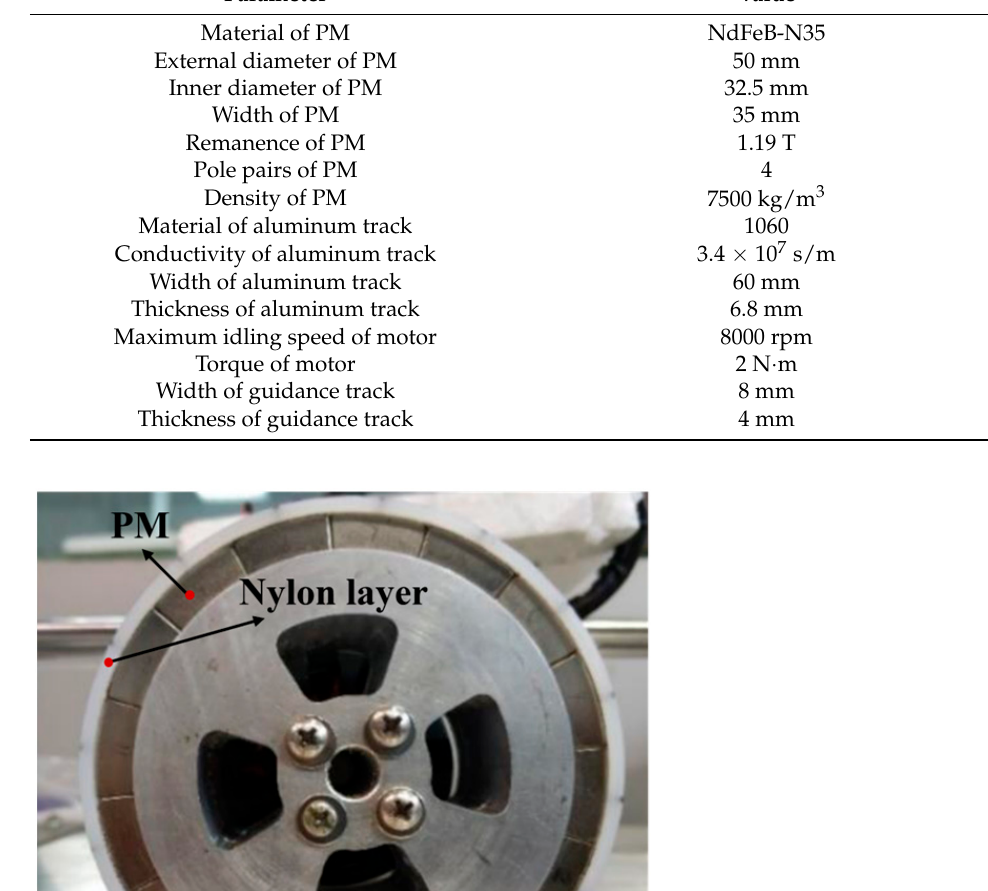
Table 4. The specific design parameters of the annular PM EDS experimental prototype.